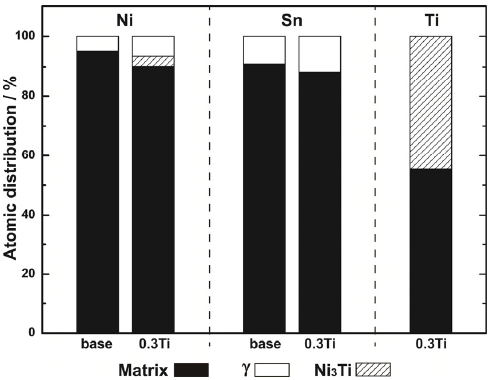
Figure 7. The distribution of Ni, Sn, and Ti atoms among the matrix, γ phases, and Ni 3 Ti precipitates in base and 0.3% Ti alloys aged at 400 ◦ C for 4 h.